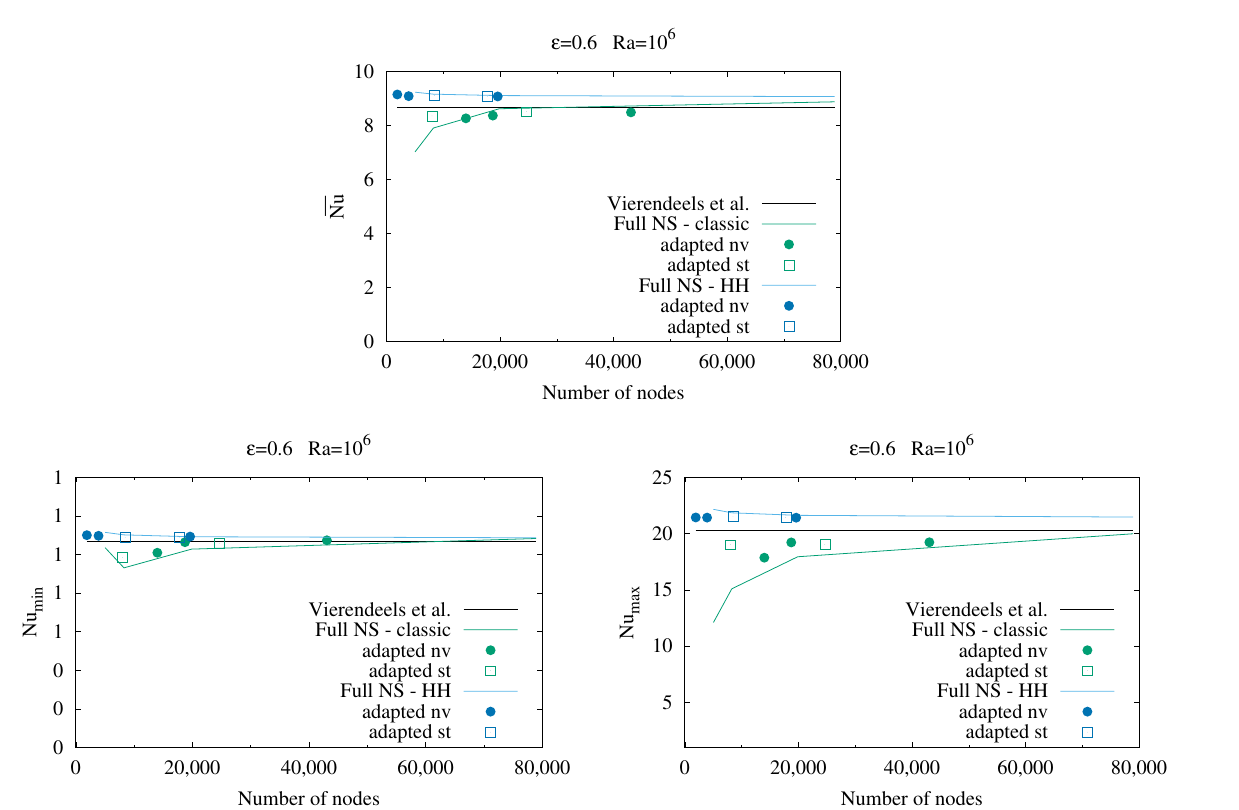
Figure 12. Buoyancy-driven square cavity. Nusselt numbers along hot vertical wall for (cid:101) = 0.6 and Sutherland viscosity for adapted meshes.